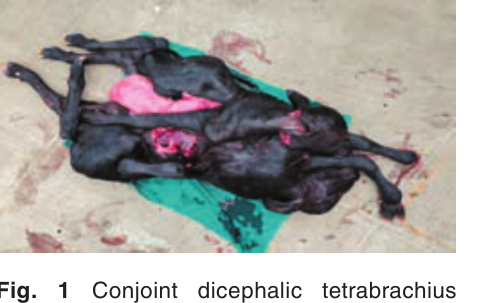
Fig. 1 Conjoint dicephalic